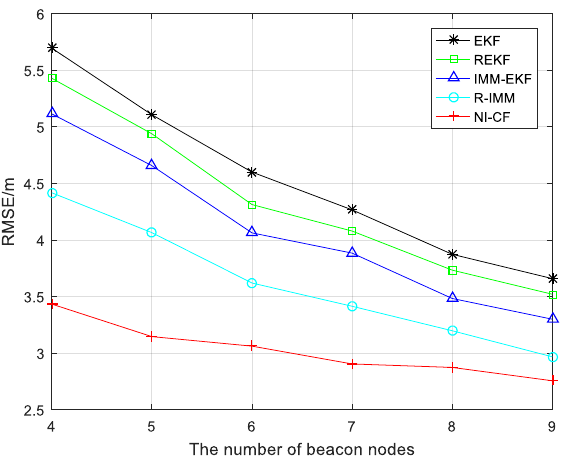
Figure 9. The RMSE versus the number of beacon nodes.